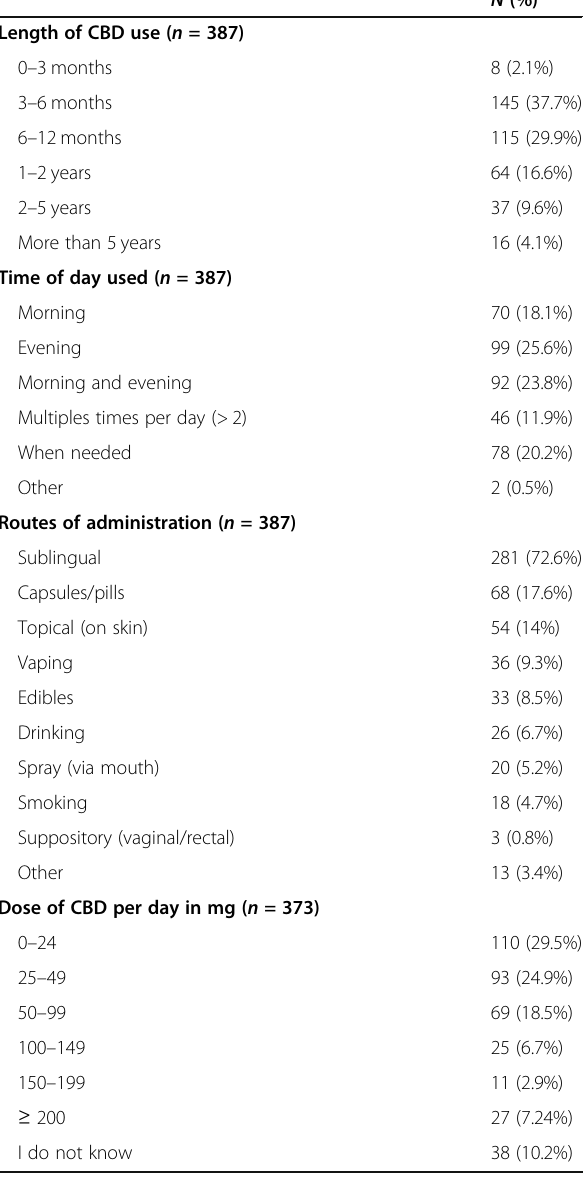
Table 2 Patterns of cannabidiol use in 287 cannabidiol